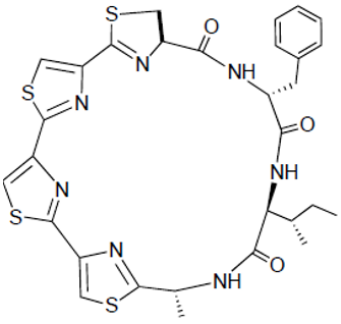
Figure 9. Structure of marthiapeptide A